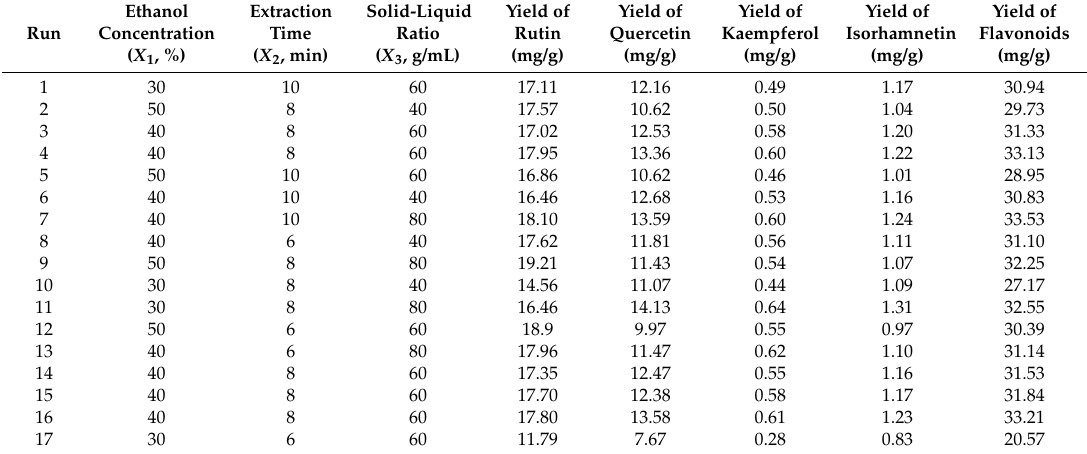
Table 1. Response surface of the BBD and results for extraction yield of flavonoids from Flos sophorae.